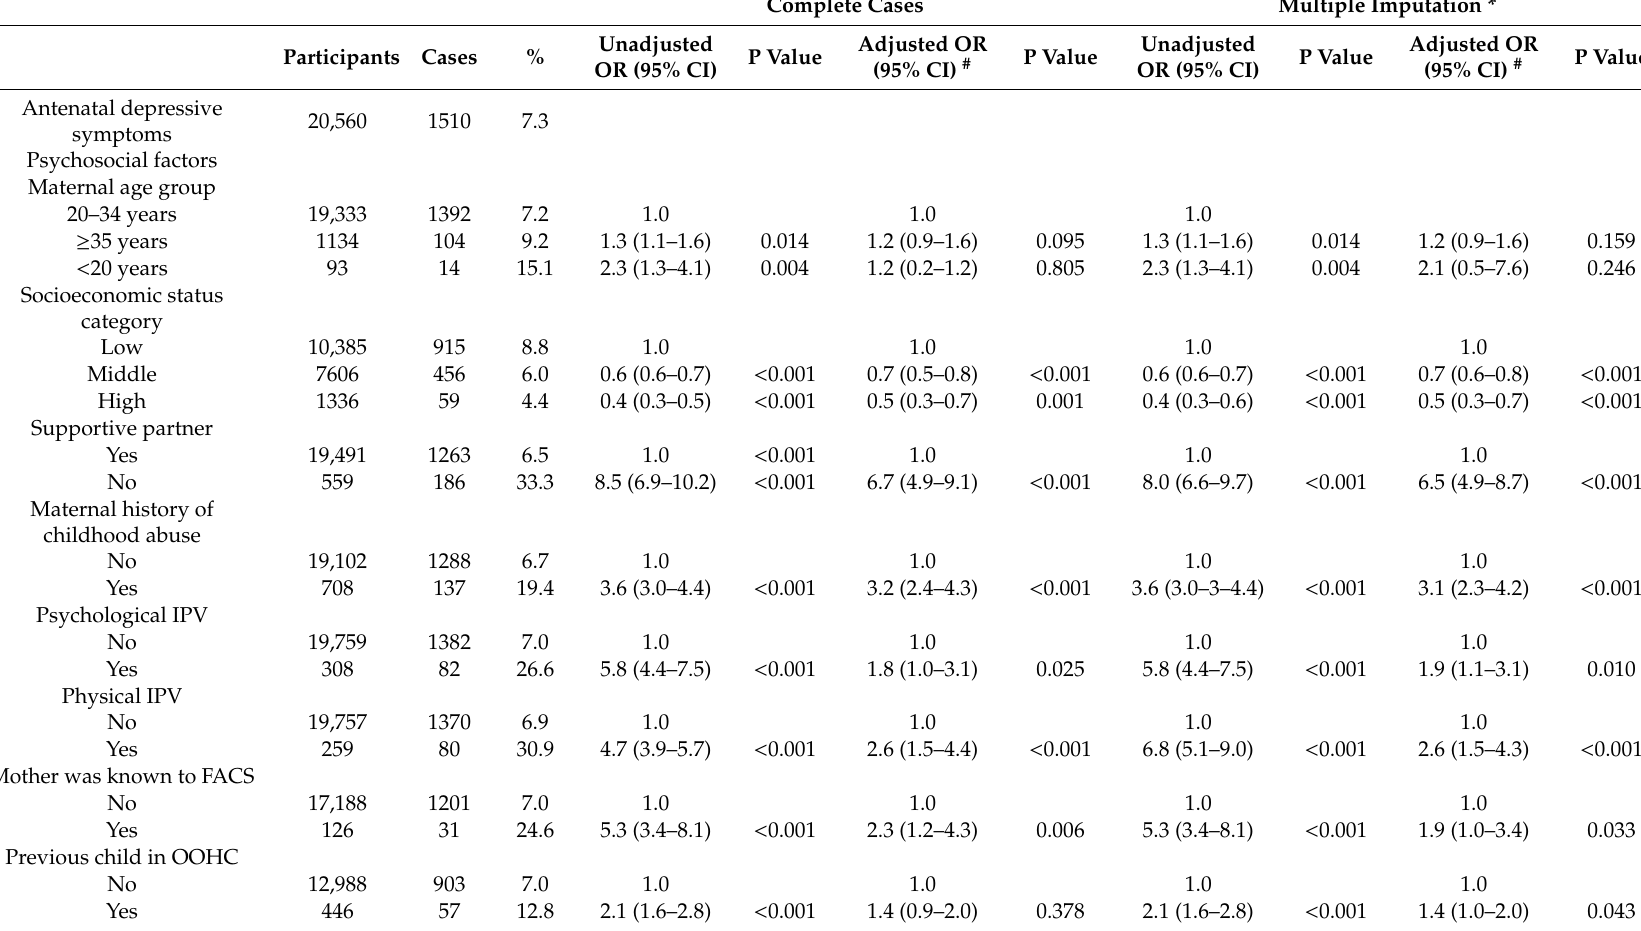
Table 2. Associations between the study factors and antenatal depressive symptoms (EPDS ≥ 13) in South Western Sydney and Sydney Local Health Districts,